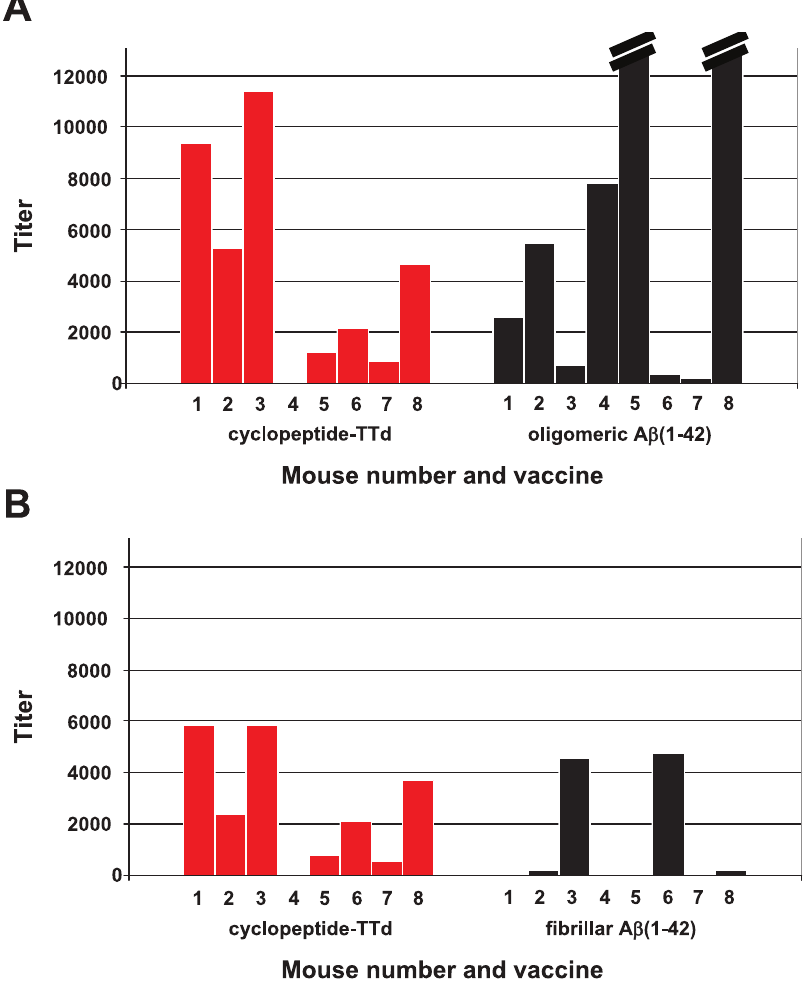
Figure 5. IgG response of individual Balb/c mice against A b (1–42) as determined by ELISA. As indicated on the x-axis, groups of eight mice were immunized with cyclo[A b (22–28)-YNGK 9 ]-TTd, oligomeric A b (1–42), or fibrillar A b (1–42). A , coating antigen: oligomeric A b (1–42); B , coating antigen: fibrillar A b (1–42). A mouse with a serum titer # 100 is considered to be a non-responder. The two titers out of range in the right panel of A have values of 40 6 10 3 and 50 6 10 3 . The figure demonstrates that anti- cyclo[A b (22–28)-YNGK 9 ] antibodies recognize oligomeric and fibrillar A b (1–42).